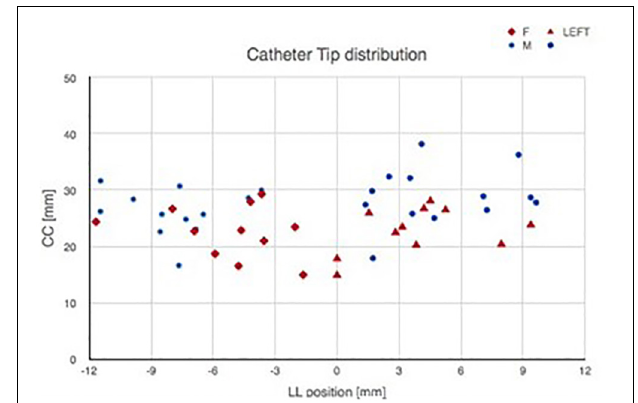
FIGURE 9 | Catheter tip distribution against the patient